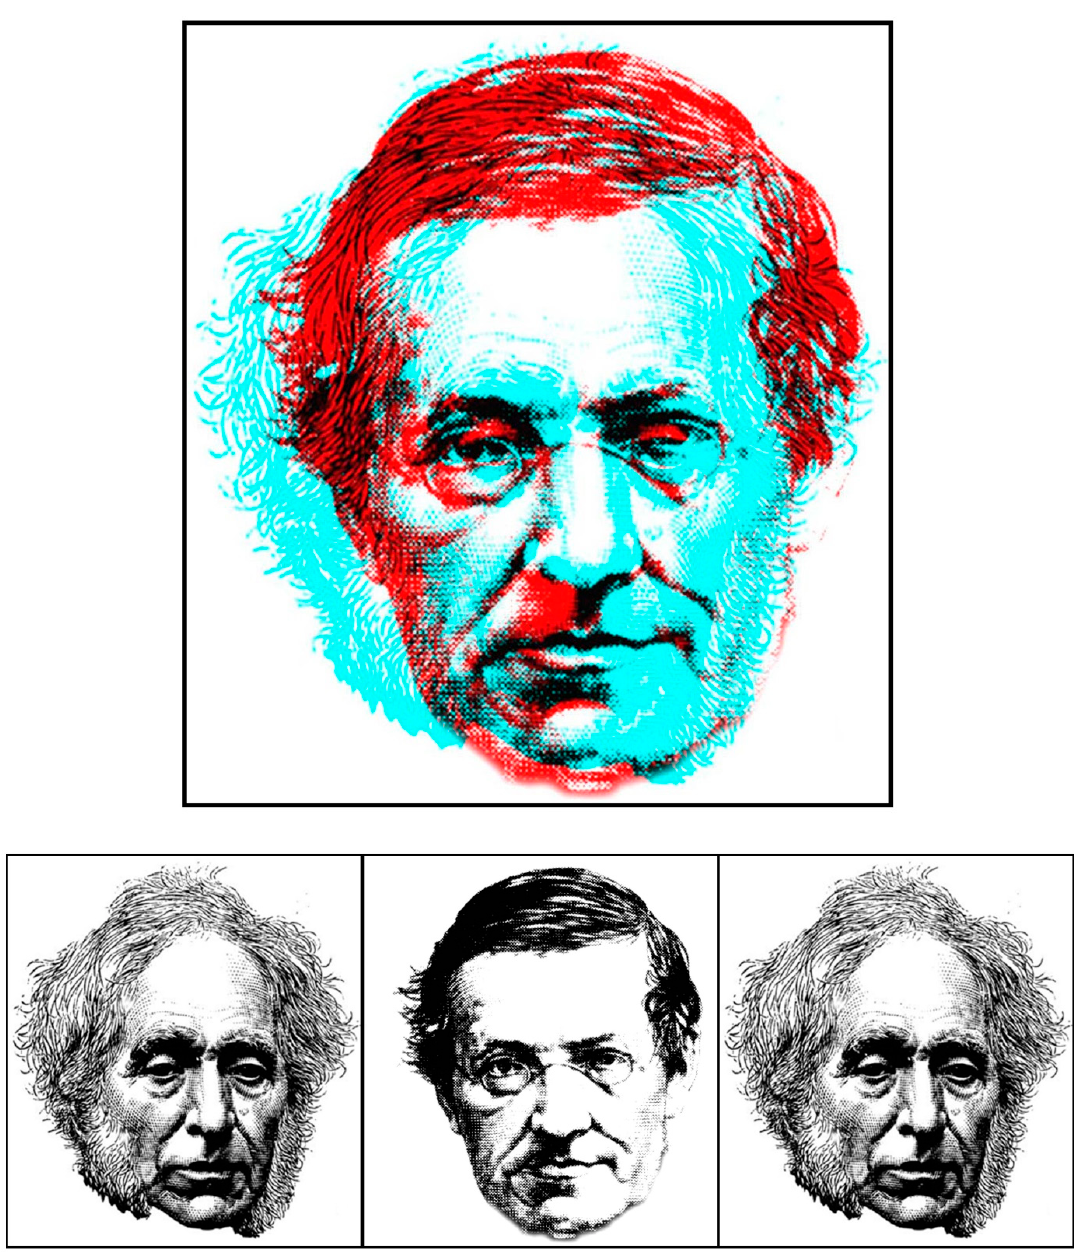
Figure 2. Rivalling portraits of David Brewster and Charles Wheatstone by Nicholas Wade.